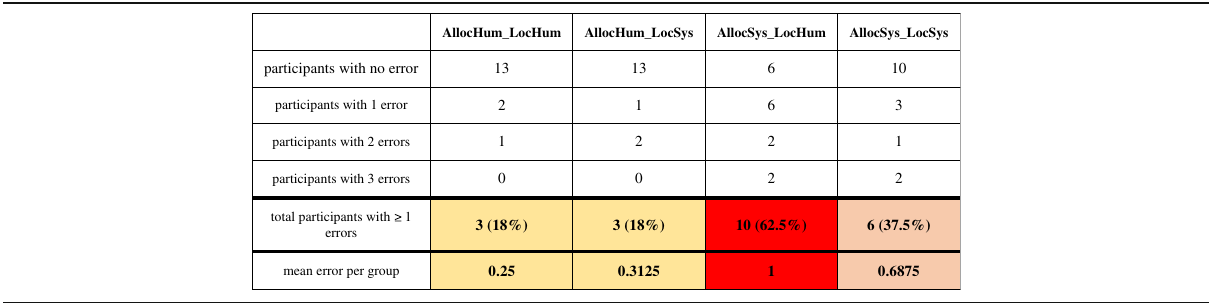
Table 5 Different numbers of navigation errors across groups during the experimental Phase 2 indicating varying degrees of recalling the acquired spatial knowledge of the traversed